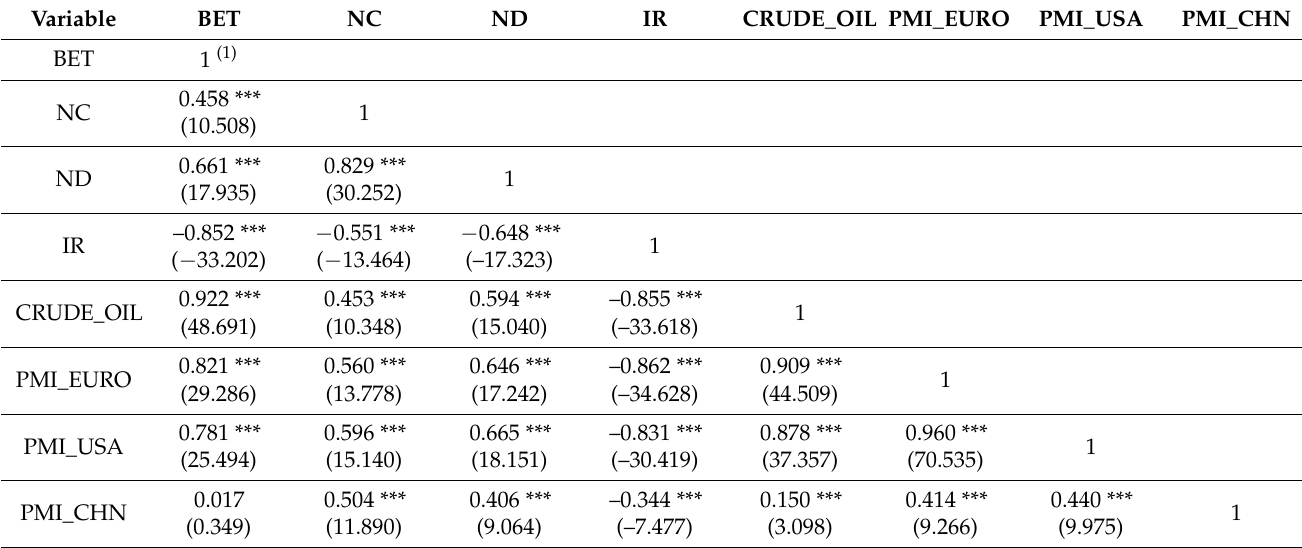
Table 3. Bivariate correlations between considered variables.